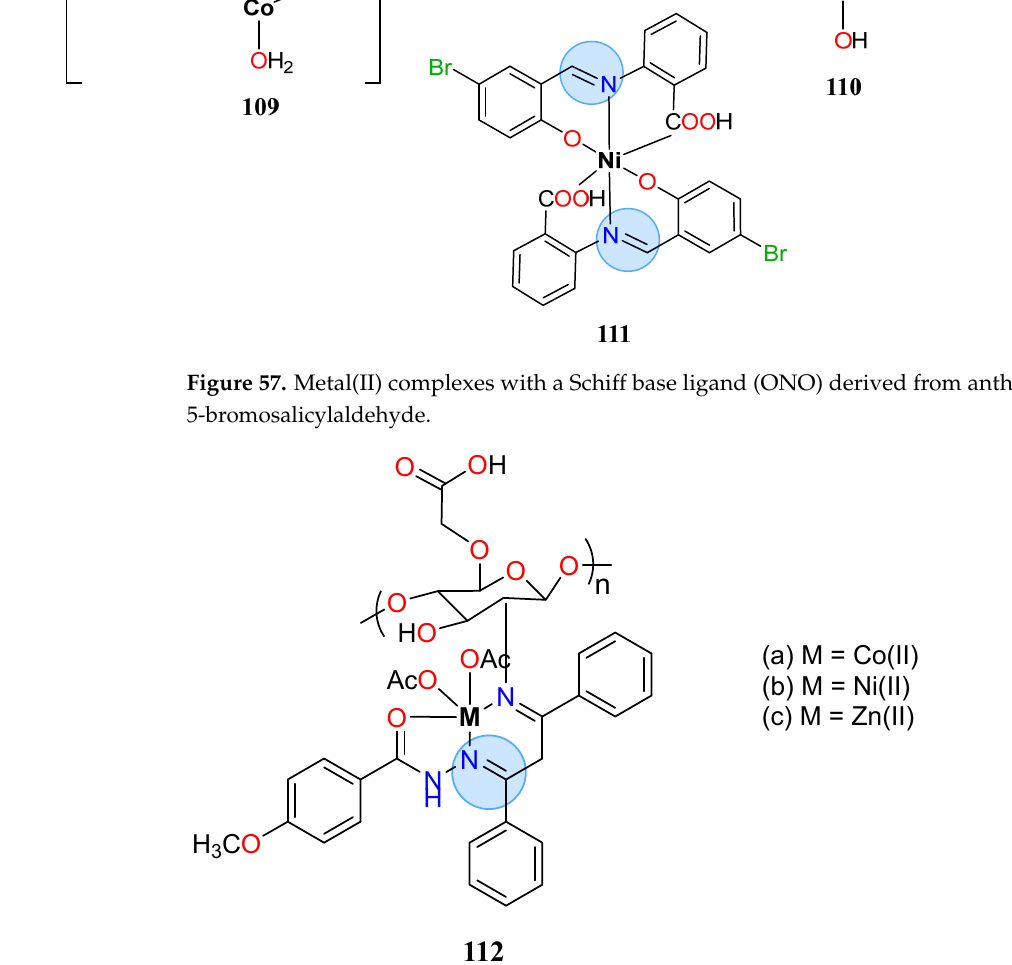
Figure 57. Metal(II) complexes with a Schiff base ligand (ONO) derived from anthranilic acid and 5 ‐ bromosalicylaldehyde.